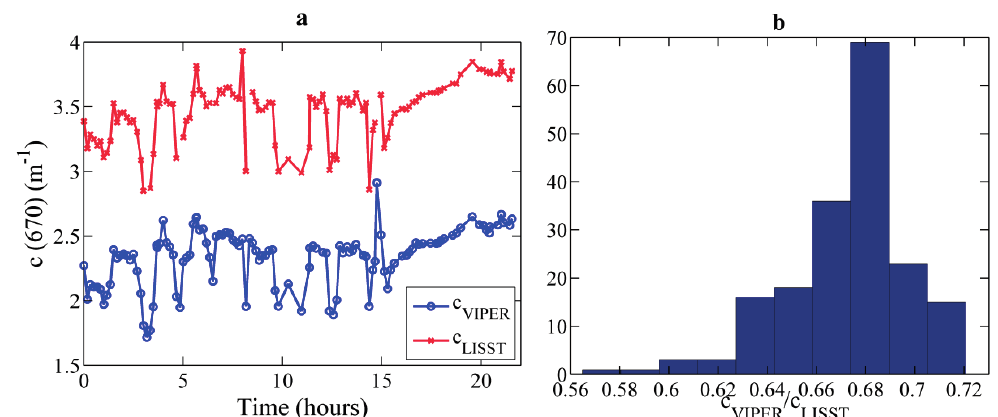
Figure 13. ( a ) Comparison of beam attenuation at 670 nm measured by VIPER (blue) and by LISST-100X (red) during vertical profiling at a fixed station in Alfacs Bay in June 2013; ( b ) Histogram with the frequency of occurrence of the c VIPER /c LISST